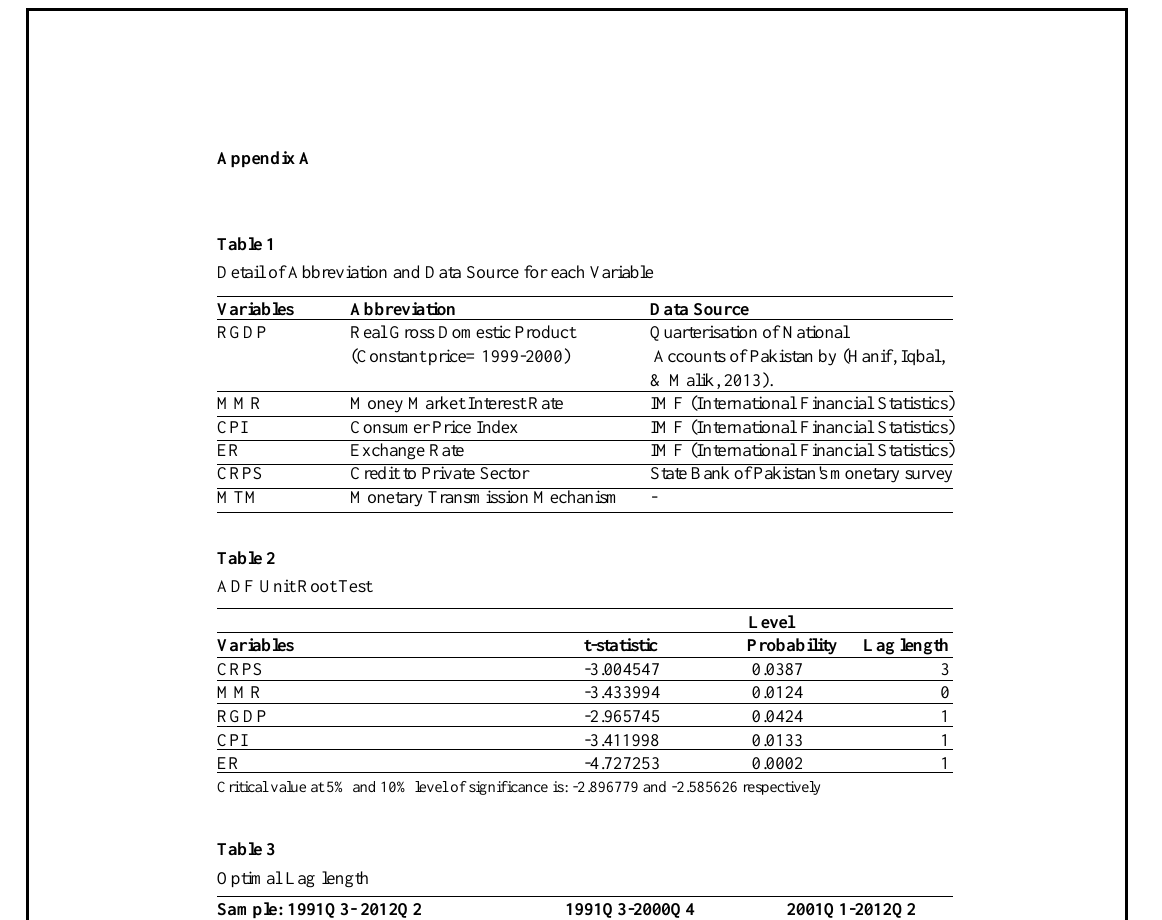
Optimal Lag length Sample: 1991Q3-